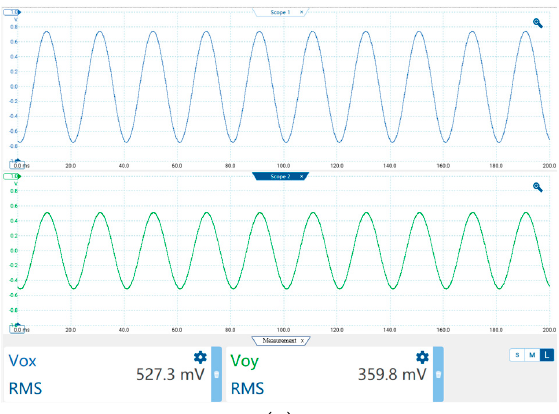
Figure 7. Error characteristics of actual output voltage and reconstructed voltage. Figure 8a shows the voltage output waveform of the sensor before and after capaci- tance conversion when the voltage source output voltage is 200 V rms . In the experiment, the reconstructed voltage was compared with the measurement results of the Tektronix P5202A differential probe. Figure 8b shows a comparison of the reconstructed signal with the actual signal. The black waveform is the real-time waveform of the Tektronix P5202A differential probe, and the green waveform is the waveform reconstructed using Equation (11). Figure 8b shows that the time difference Δ t between two waveforms is 314.8 µs. For a power frequency voltage with a period T of 0.02 s, the relative phase error is Δ t /T·100%= 1.57%.